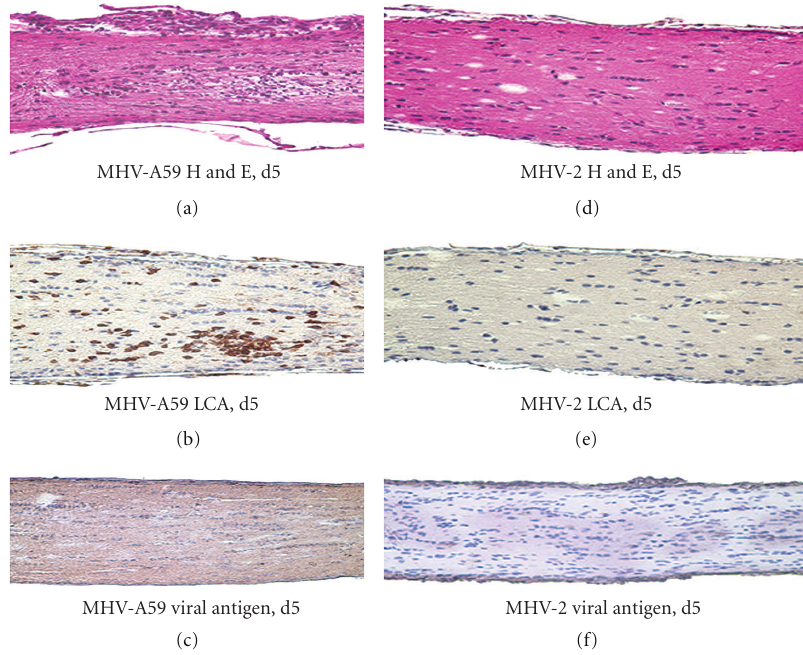
Figure 7: Optic nerve histopathology from MHV-A59-infected and MHV-2-infected mice. Longitudinal sections (5 μ m thick) of optic nerve from MHV-infected mice are shown. Numerous inflammatory cells are evident in an MHV-A59-infected optic nerve with ON 5 days post inoculation stained by H & E (a) and LCA (b). Optic nerve, 5 days post inoculation, with MHV-2 (d) shows a lack of inflammation, with no LCA staining (e) detected. Viral antigen staining of optic nerve from an MHV-A59-infected mouse (c) shows low-level axonal staining whereas no viral antigen is detected in MHV-2-infected (f) mouse optic nerve. Photographs shown at original magnification x20. (adapted from the work of